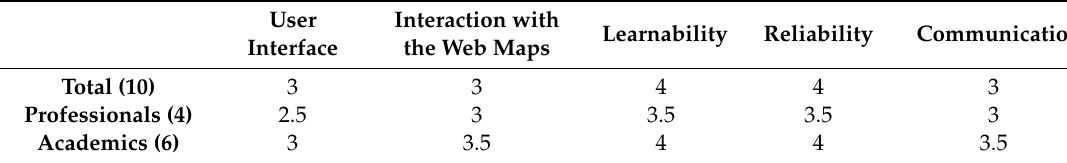
Table 1. Median score of participatory GIS usability scale responses between academics and professionals (10